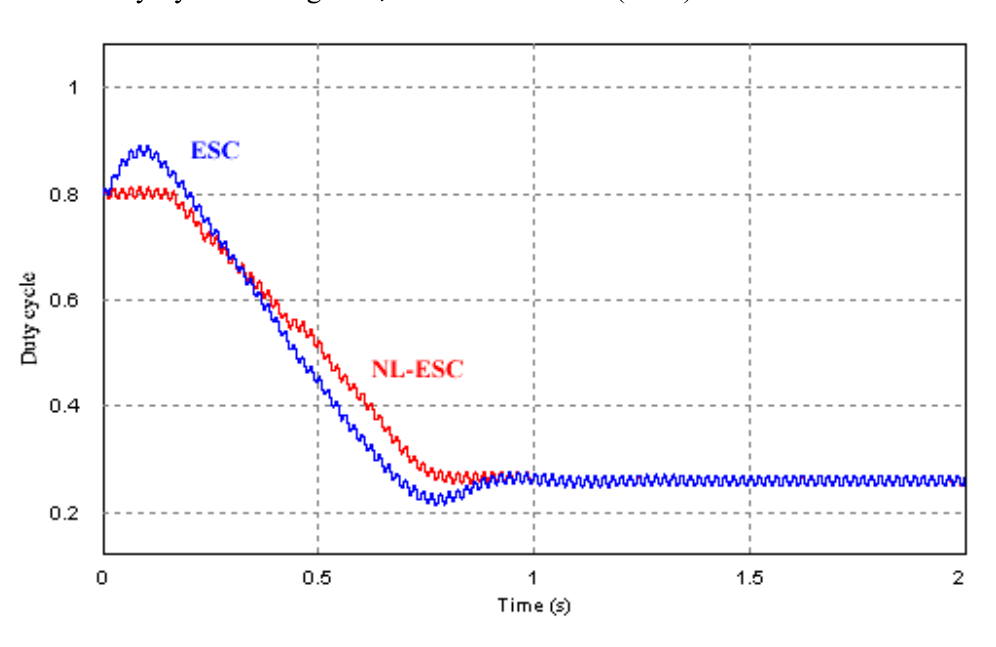
Figure 9. Transient of duty-cycle starting at D Transient of duty-cycle starting at D